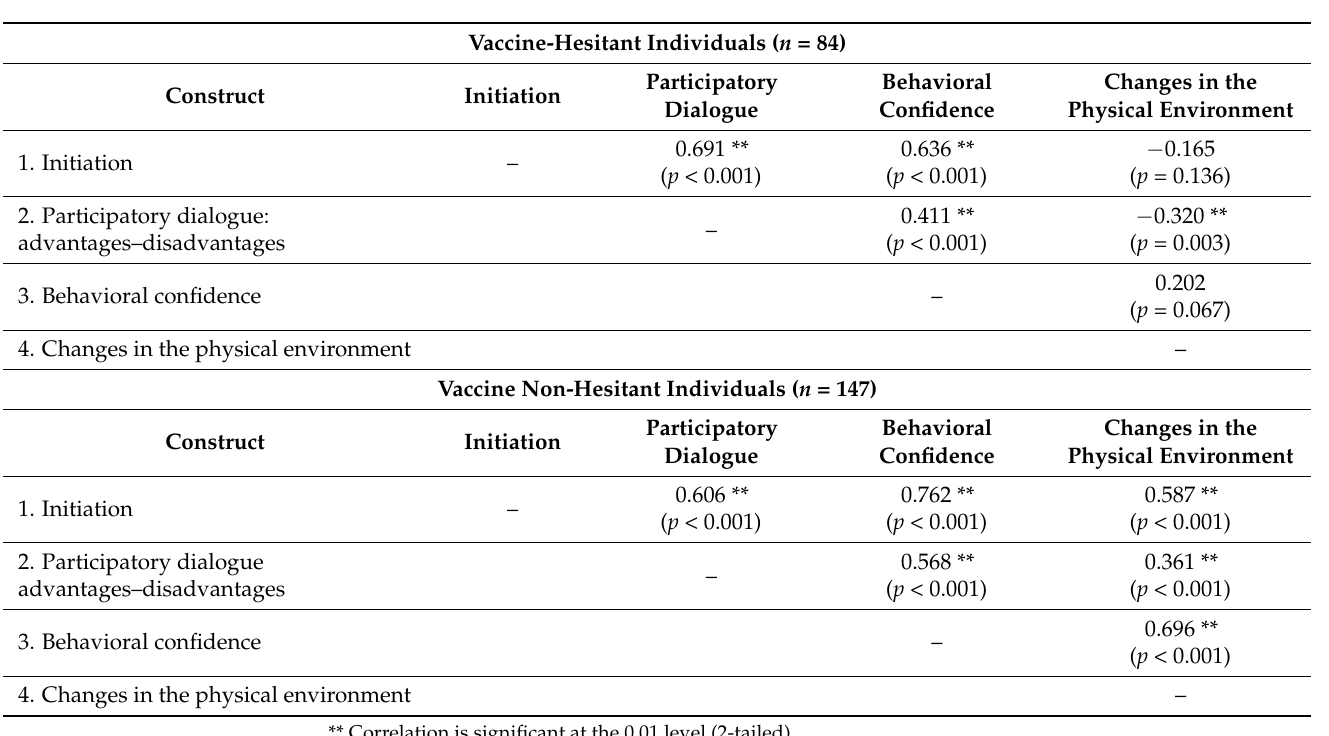
Table 3. Zero-order correlation matrix of study variables for initiation of COVID-19 vaccination behavior.